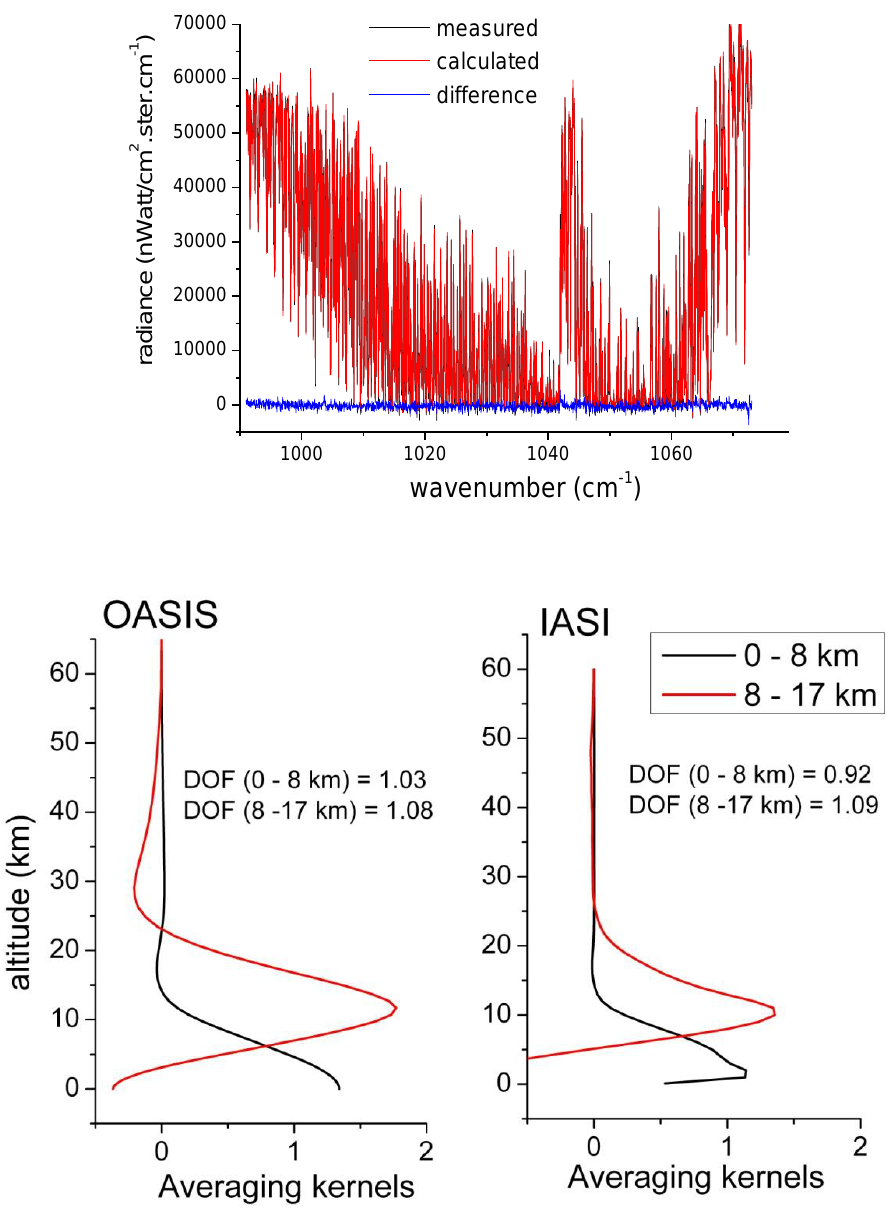
Fig. 2. Upper plot: Example of an atmospheric spectrum recorded with OASIS on 31 March 2009 at 12:58p.m. (UT), showing the well- known O 3 absorption bands around 10 microns. Black: the measured spectrum. Red: the calculated spectrum. Blue: the difference between the measured and calculated spectra. Lower plot left (right): OASIS (IASI) typical averaging kernels in partial column space from ground to 8km and 8 to 17km in black and red respectively.